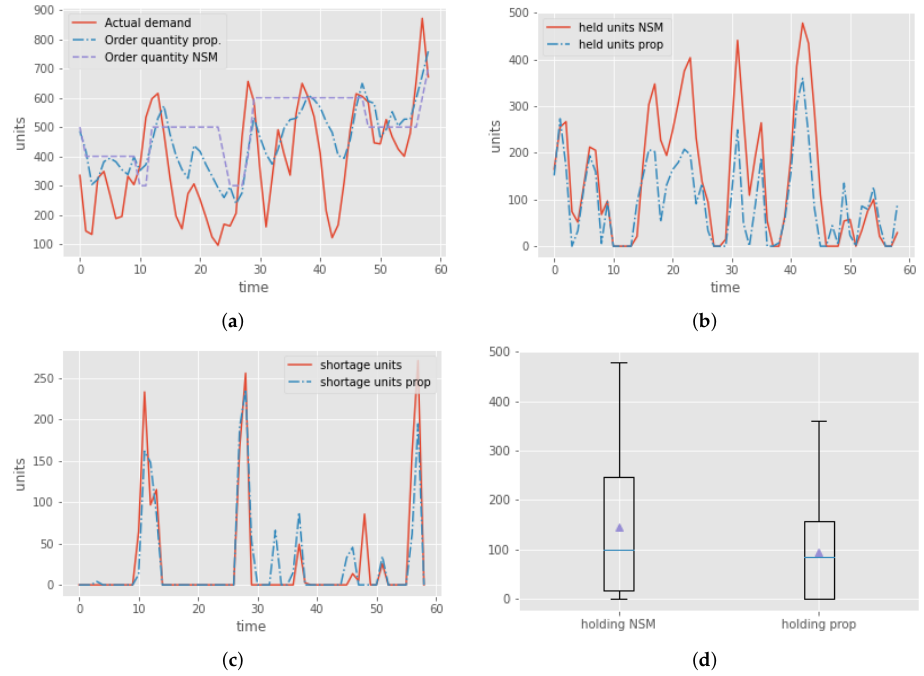
Figure 1. ( a ) Optimal value of the order quantity over time, as determined by the models, ( b ) held units on inventory, as determined by the models, ( c ) shortage units as determined by the models, and ( d ) summary of the simulation; position of the arithmetic means are highlighted by a